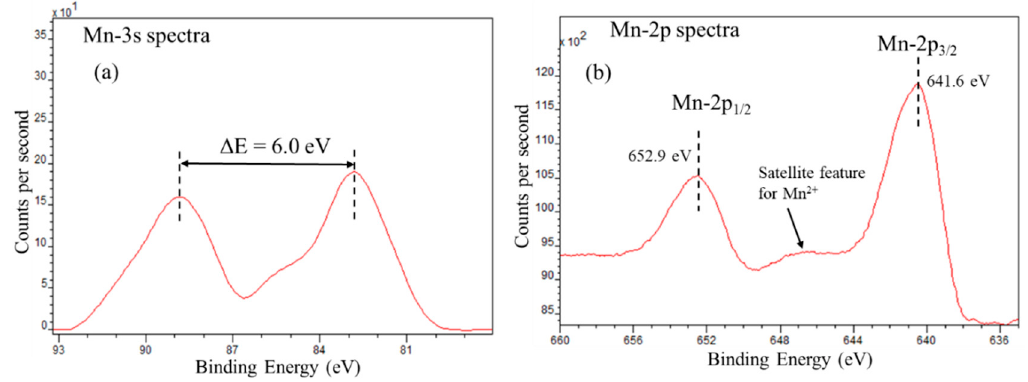
Figure 5. X-ray photoelectron (XPS) spectra for manganese in MnPMo/TiO 2 -Al 2 O 3 catalyst, ( a ) Mn-3s spectra and ( b ) Mn-2p spectra.